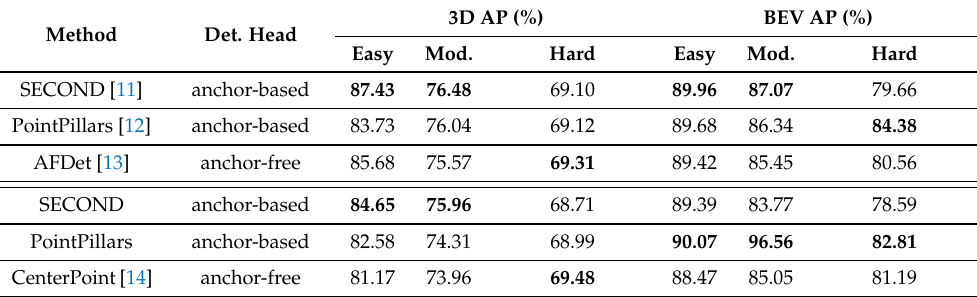
Table 2. Performance comparison of existing voxel-based anchor-free/-based detectors on the KITTI dataset. Above are the validation results of car detection by the SECOND, the PointPillars and the AFDet approach. The AFDet only provides results for the KITTI validation dataset. Below are the car detection results of the SECOND, the PointPillars and the CenterPoint approach on the KITTI test dataset.